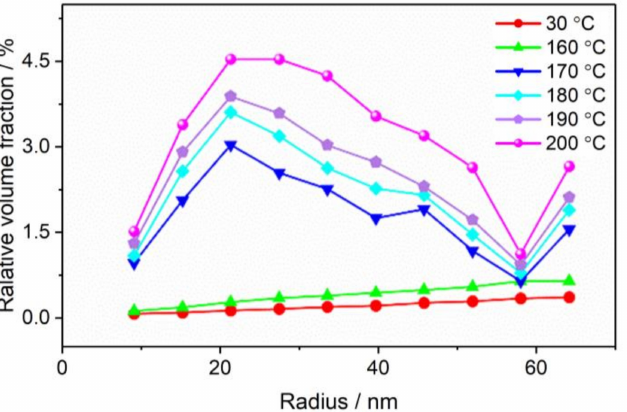
Figure 6. Pore size distribution of CL-20 before and during phase transition.